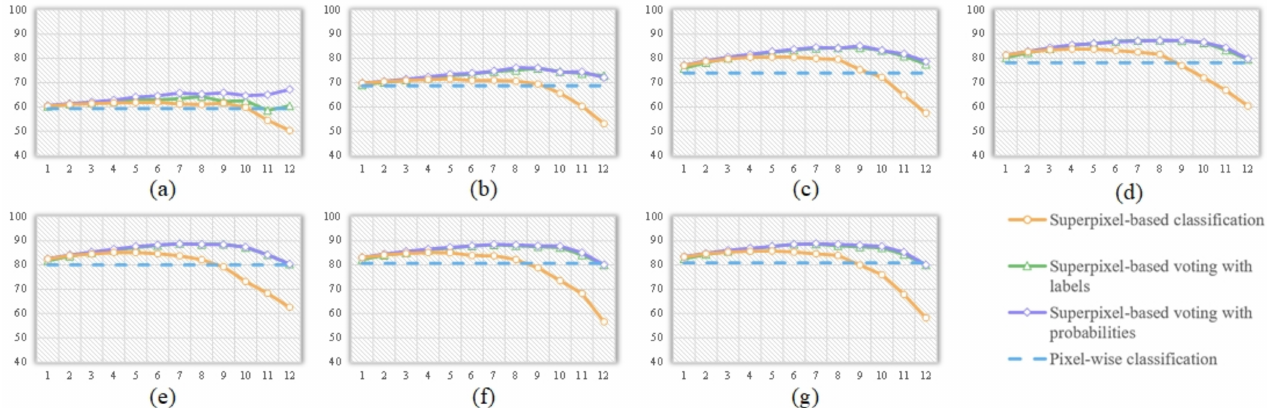
Figure 6. Accuracies given by the single-scale approaches with ( a ) 25, ( b ) 50, ( c ) 100, ( d ) 150, ( e ) 200, ( f ) 250, and ( g ) 300 training samples per class for the Hanchuan dataset using SVM, where the vertical axis represents the OAs, and the horizontal axis represents the superpixel segmentation